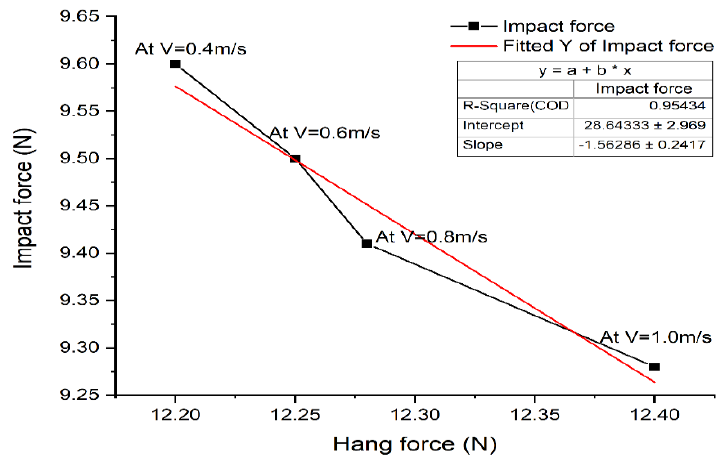
Figure 13. Relationship between hang force and impact force.